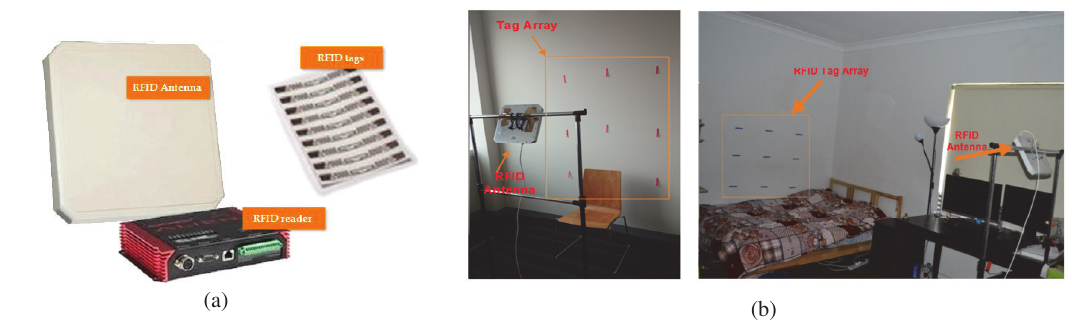
Figure 8: (a) RFID tags/reader/antenna (b) Lab setting (left) and Bedroom setting (right)